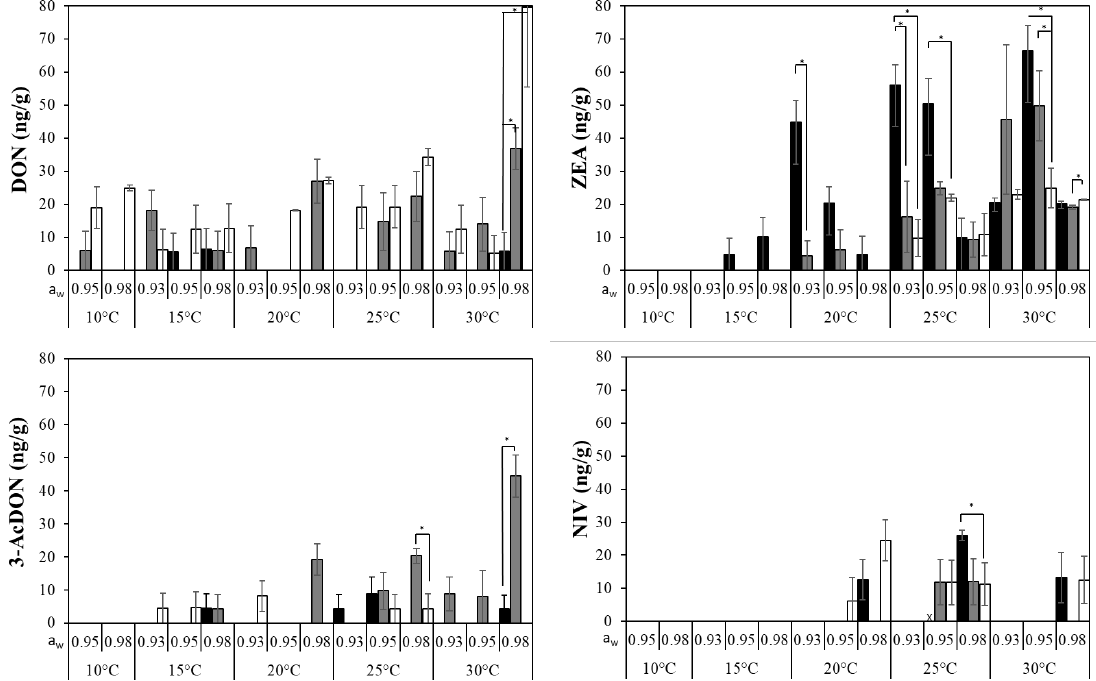
Figure 5. Deoxynivalenol (DON), 3-acetyl deoxynivalenol (3Ac-DON), zearalenone (ZEA) and nivalenol (NIV) produced by F. asiaticum strains ( , 982; , 082; , Ch024b) when colonizing a wheat-based medium for 10 days. Vertical bars indicate standard deviation. Asterisks indicate significant differences between strains using Wilcoxon pair comparison.